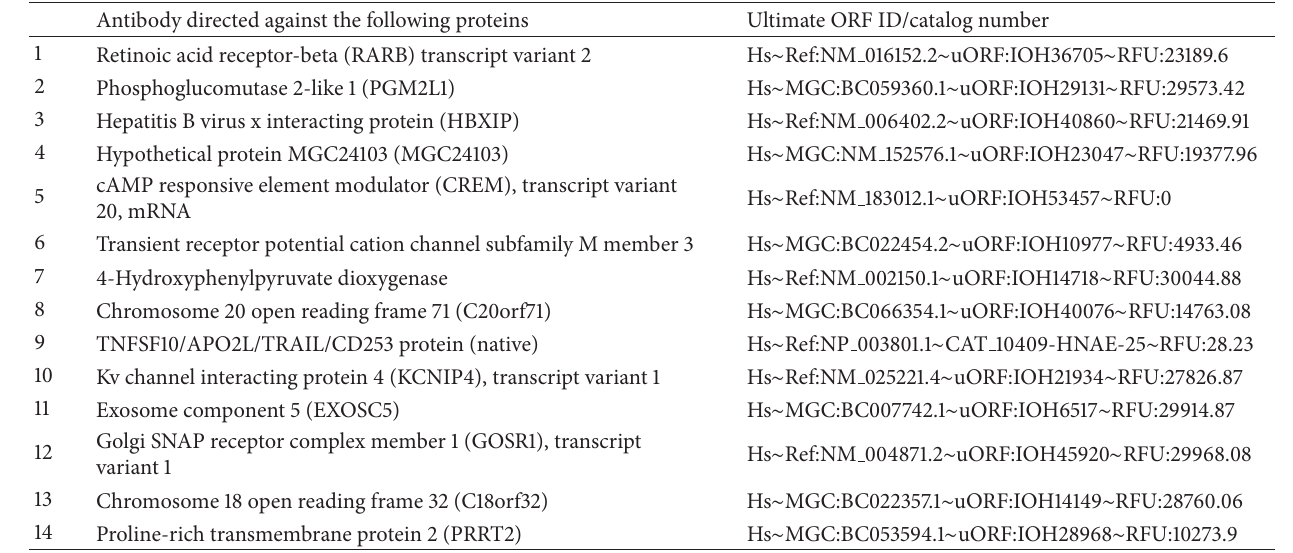
Table 3: The 14 autoantibodies building the